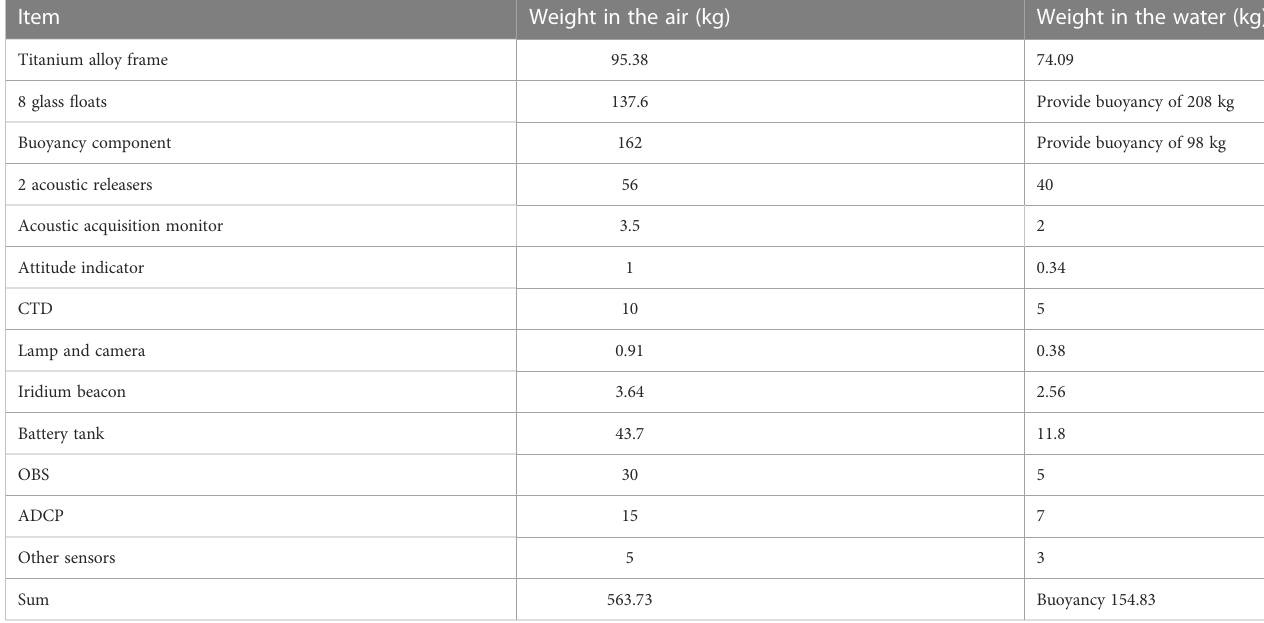
TABLE 2 Lander weight and buoyancy